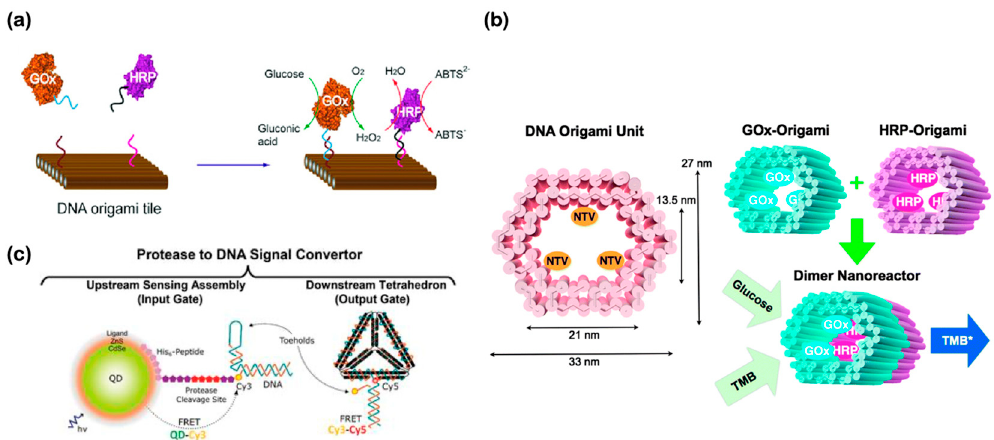
Figure 7. Hybrid enzyme-DNA biosensors: ( a ) DNA origami tile combined with programmable DNA sequences acts as a platform to control the spatial arrangement of cascade enzymatic activities. For instance, the reaction rate between GOx and HRP is tunable by adjusting the staple strands of the DNA origami tile; ( b ) A reactor-like system utilizes 3D DNA origamis to enhance enzymatic activities as a new confined space synthesis. In particular, GOx and HRP are internalized inside the interior of DNA origamis to prevent unintended reactions until the target is present; ( c ) Coupling DNA nanostructure and programmable DNA sequences to semiconductor quantum dots and peptides to construct a hybrid protease-to-DNA signal converter. Upon sensing the presence of target protease, the system converts a protease-peptide reaction into subsequent DNA hybridization reactions. Adopted with permission from [155]. Copyright 2012, American Chemical Society. Adopted with permission from [158]. Copyright 2015, The Royal Society of Chemistry. Adopted with permission from [145]. Copyright 2019, Wiley & Sons.